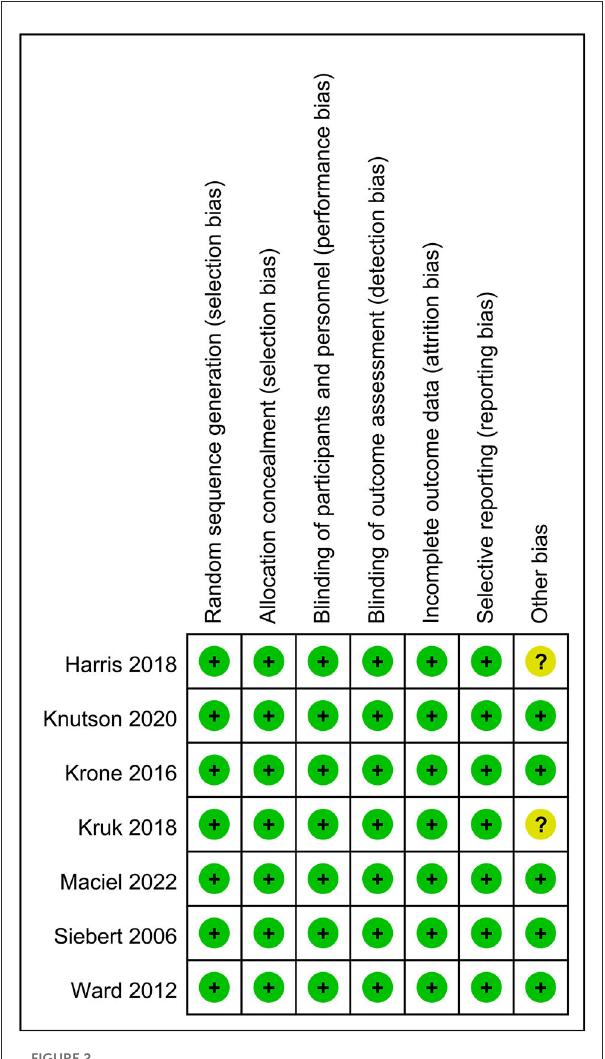
FIGURE2 Summary of the risk of bias in the included